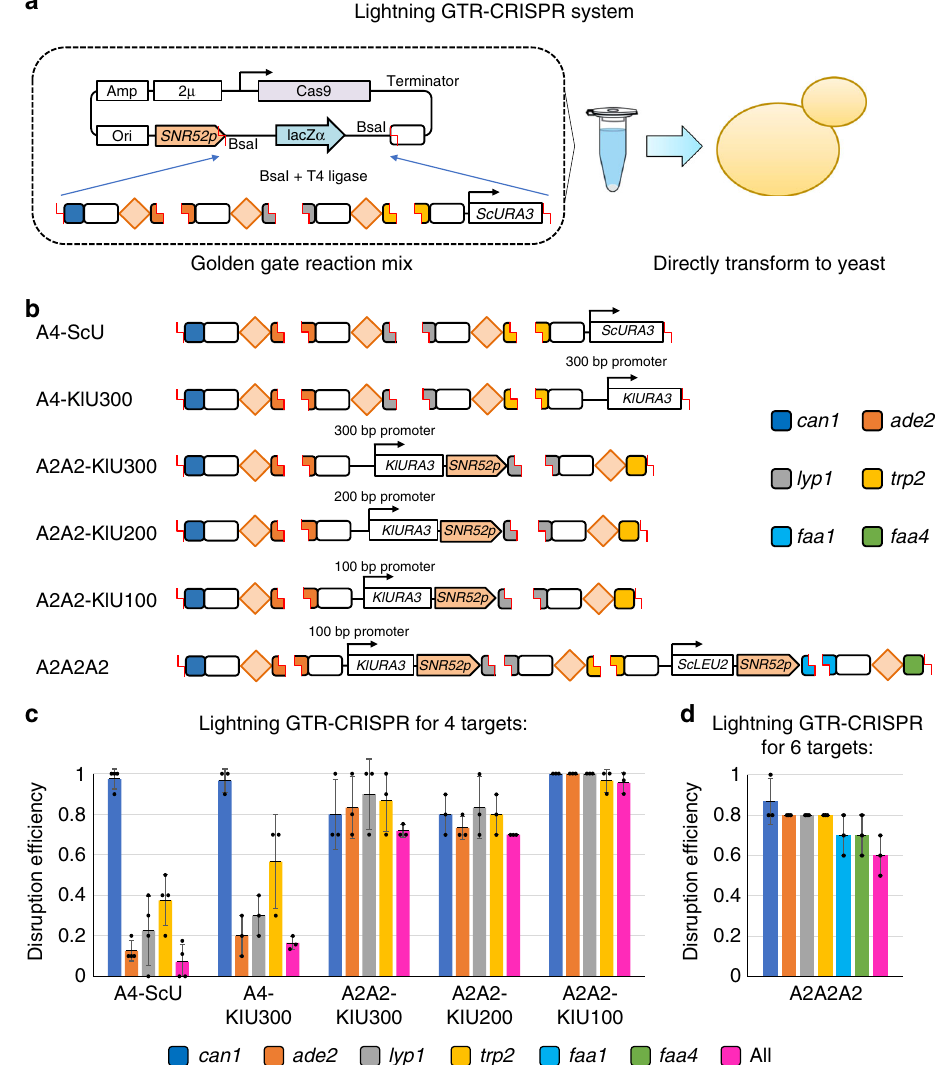
Fig. 4 Simultaneous disruptions for 4 and 6 genes using Lightning GTR-CRISPR. a Graphic representations of the Lightning GTR-CRISPR system without E. coli transformation. b Optimizations of the Lightning GTR-CRISPR system. ScU stands for S. cerevisiae URA3 gene. KlU300, KlU200, and KlU100 stand for K. lactis URA3 gene ( KlURA3 ) with its 300, 200, or 100 bp promoters, respectively. ScLEU2 stands for S. cerevisiae LEU2 gene, an additional selection marker for 6 targets. A4 represents 4 guide RNAs (gRNAs) in mode A (GTR) format, A2A2 represents total 4 gRNAs in 2 sets of GTR format, and A2A2A2 represents total 6 gRNAs in 3 sets of GTR format. c , d Results of the Lightning GTR-CRISPR systems for 4-gene and 6-gene disruptions. The data of bar charts represent mean averages of each gene or overall disruption ef fi ciencies. Each black dot represents the gene disruption ef fi ciency of 10 colonies from each biological replicate, and the error bars indicate the standard deviations of all ( n = 3) biological replicates. Source data are provided